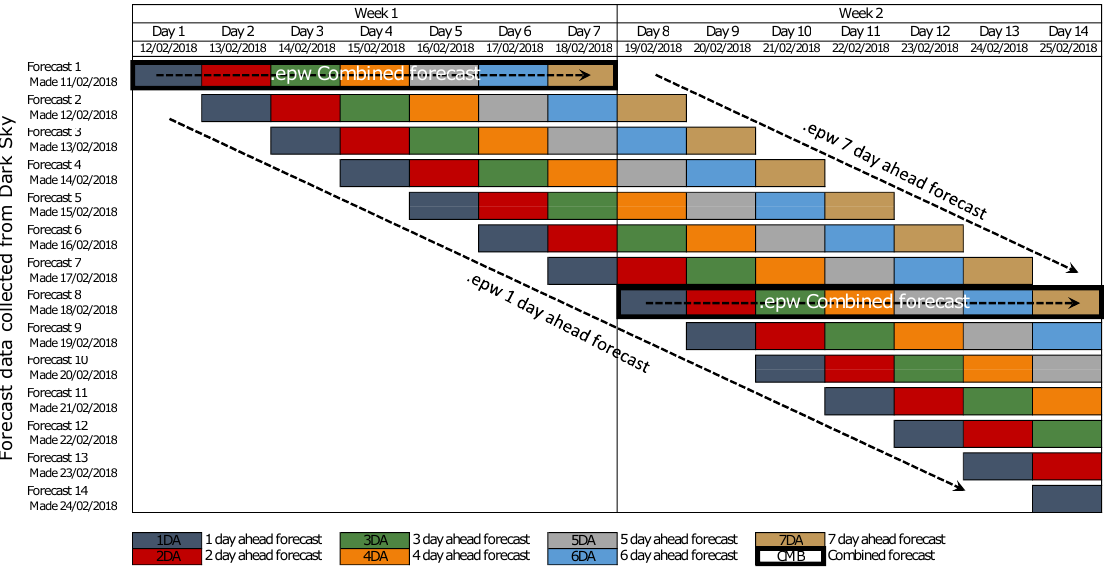
Figure 4. Organization of forecast data and construction of forecast weather files.